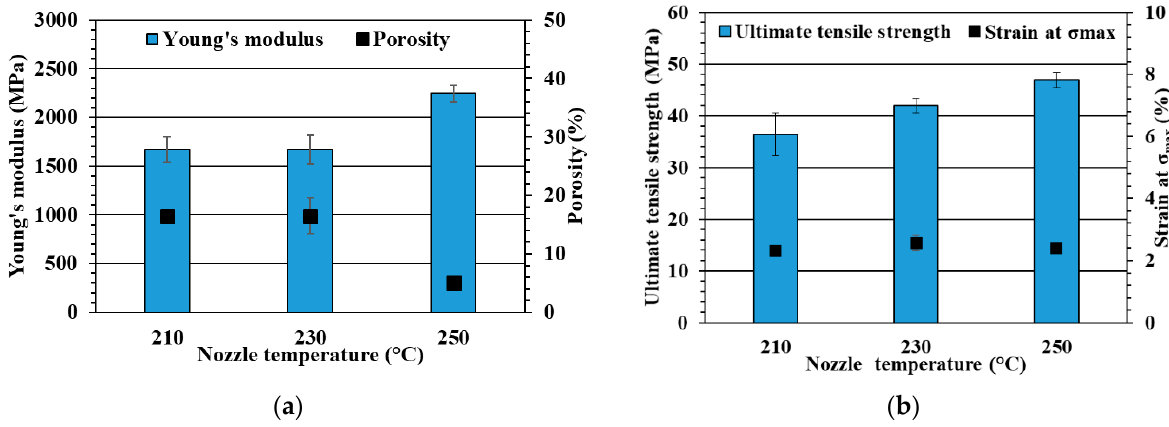
Figure 10. Influence of the nozzle temperature (210 °C, 230 °C, and 250 °C) on ( a ) Young’s modulus and porosity and ( b ) ultimate tensile strength and the strain at the ultimate tensile strength.